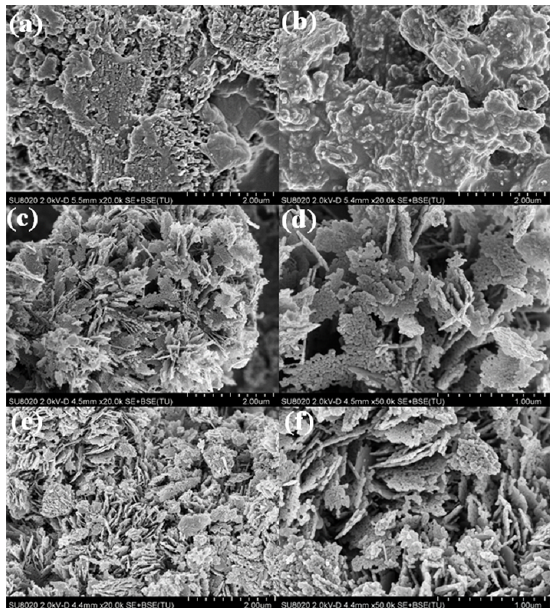
Figure 3. Scanning electron microscopy (SEM) images of ( a ) g-C 3 N 4 ; ( b ) H 2 SO 4 -C 3 N 4 ; ( c , d ) CN-2/ZnO; and ( e , f ) ZnO.